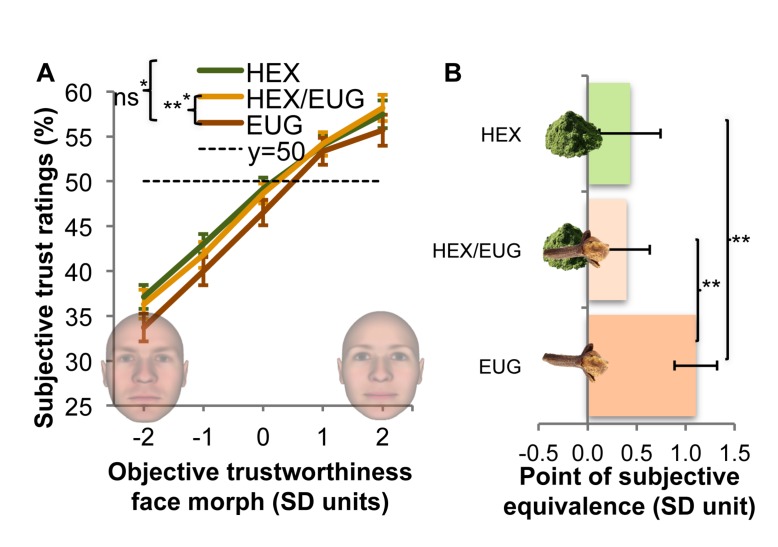
Effects of odor (hexanal: HEX, hexanal masked by eugenol: HEX/EUG; mask odor: EUG) on participants’ perceived trustworthiness of faces that objectively varied on trustworthiness (–2 to 2 SD). Main results are based on analyses controlling for subjective odor pleasantness and intensity. Error bars ± SEM. (A) Psychometric curves showing that overall trustworthiness ratings were higher for masked hexanal (vs. mask). The superscript result (∗) shows the same test without correction for pleasantness and intensity. (B) Masked and unmasked hexanal induced trust, evidenced by a significant shift (vs. mask) in the Point of Subjective Equivalence (PSE), the objective face at which 50% of subjective responses is “trustworthy” vs. “untrustworthy.” Lower values on the x-axis imply that faces objectively contained less trust. ∗P < 0.05; ∗∗P < 0.01.